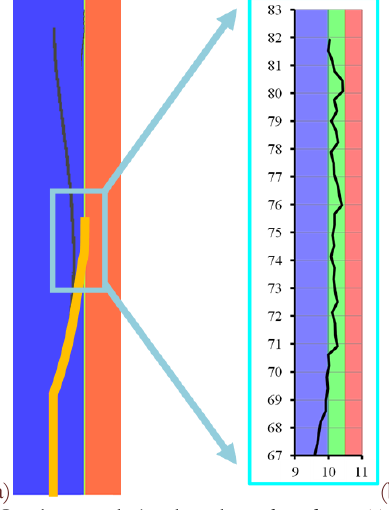
Figure 8: FEM model of phase bourdary. Figure 9: Crack growth in the phase boudary. (a) Crack path (b) Detail in phase